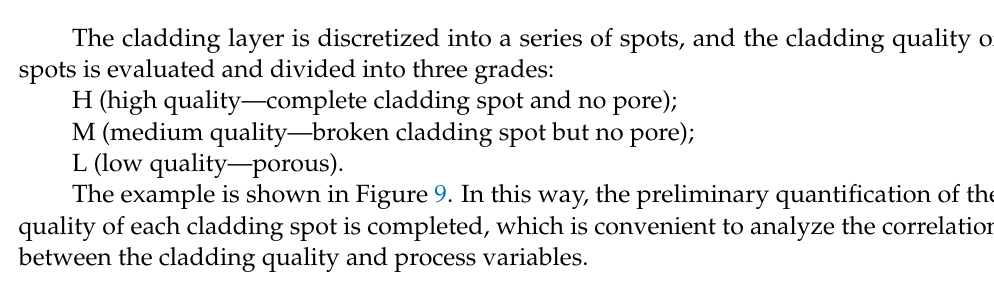
Figure 9. Cladding sample and Quality